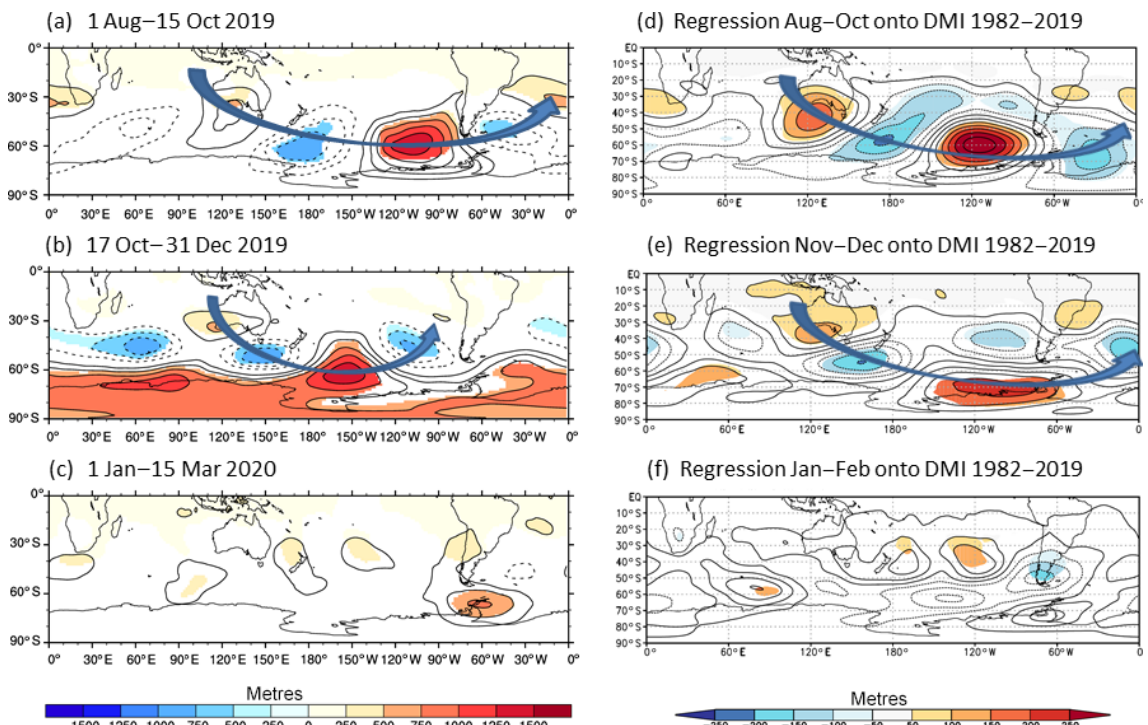
Figure A2. (a–c) Anomalies in ERA5 500hPa geopotential height relative to the 1982–2019 climatological mean based on daily data for (a) 1 August to 15 October 2019, (b) 17 October to 31 December 2019, and (c) 1 January to 15 March 2020. The averaging periods were shifted slightly to maximize the signal of the Indian Ocean Dipole (IOD) during August through mid-October and then the abrupt appearance of negative Southern Annular Mode (SAM) as a result of the coupling of the polar stratospheric warming down to the surface that occurred beginning around 17 October 2019 and lasting through the end of December 2019. Both the IOD and the negative SAM disappeared during January to mid-March 2020. Shading indicates where the magnitudes of the anomalies are larger than 1.6 standard deviations, thus indicating where the positive anomalies fall above the 95th percentile and the negative anomalies below the 5th percentile. (d–f) Linear regression of the 500hPa geopotential height anomaly onto the Dipole Mode Index (DMI) for the equivalent period based on monthly data from 1982 to 2019. Shading indicates regression is significant at p < 0 . 10. The regression coefficients are scaled by 1 standard deviation of the DMI so that the maps represent the height anomaly that would be accounted for by 1 standard deviation in DMI for (d) August to October, (e) November to December, and (f) January to February. The blue arrows depict idealized Rossby wave-train ray paths and highlight the shortening of the Rossby wavelength in November/December 2019. The regressions were computed using the Royal Netherlands Meteorological Institute (KNMI) Climate Explorer (see http://climexp.knmi.nl/, last access: 2 April 2020, Oldenborgh and Burgers,